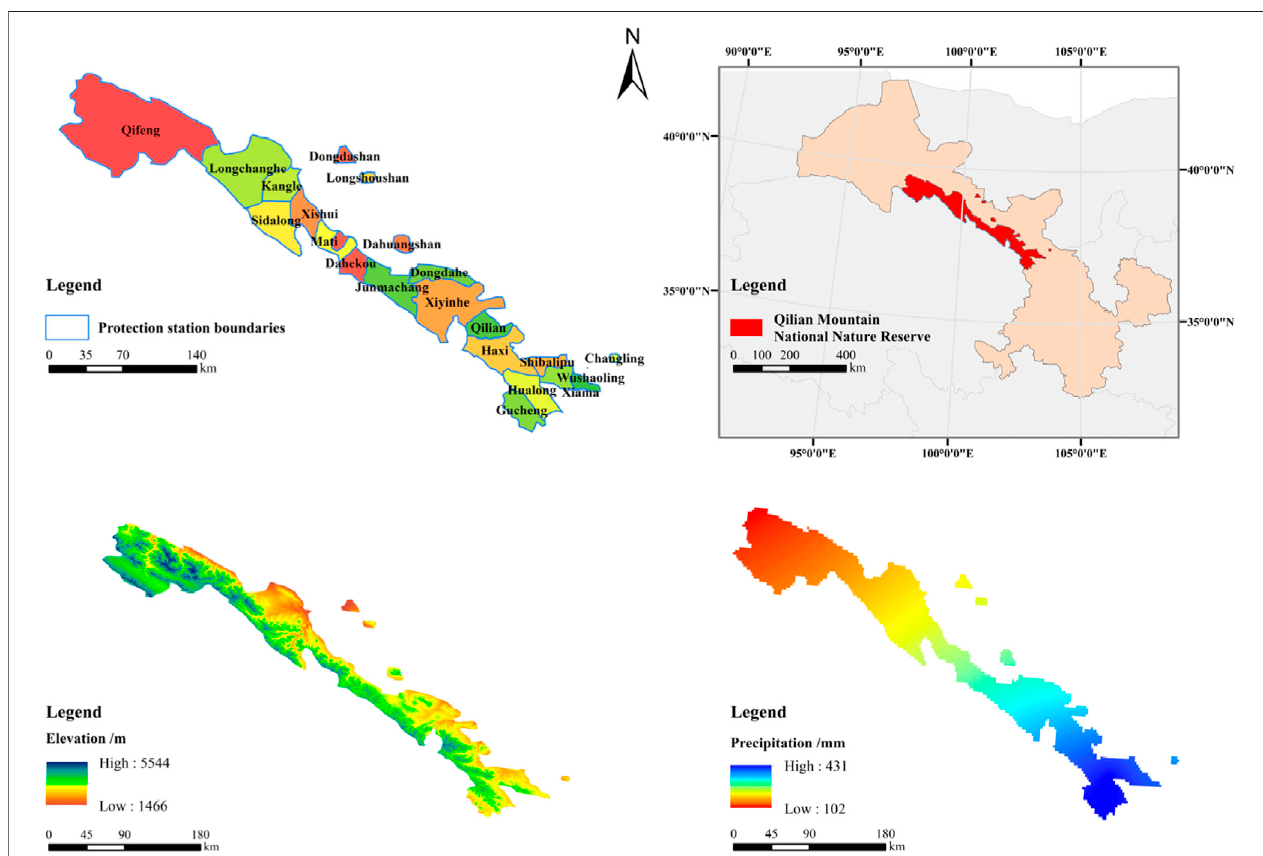
FIGURE 1 | The geographic location ofQifeng, Xishui, and Sidalong Forest Farms in the National Nature Reserve of Qilian Mountains with the elevation and annual precipitation maps.